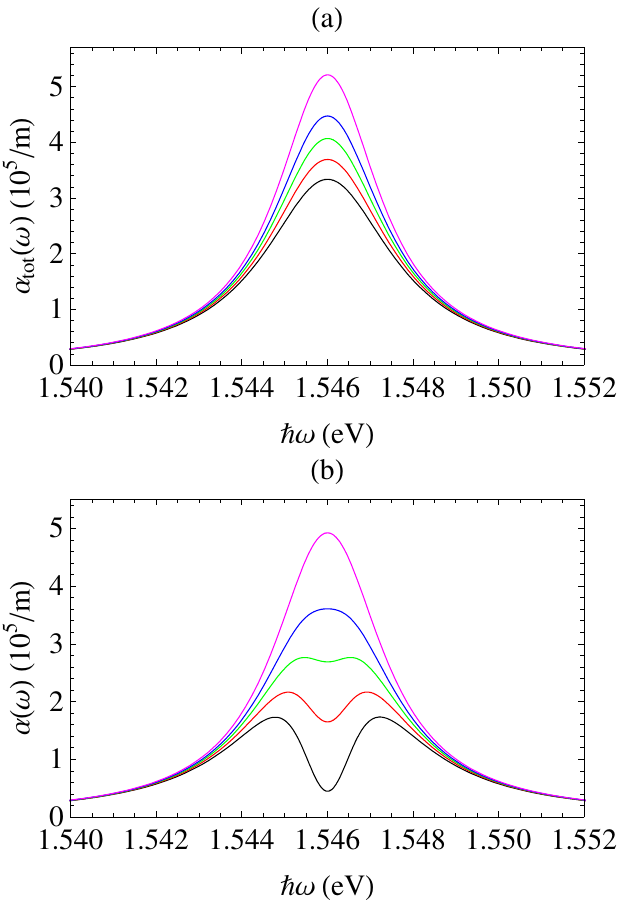
Figure 2. (Color online) The OAC α tot ( ω , I , d ) ( a ) and α ( ω , I , d ) ( b ). The various curves are for different distances from the surface of the metallic nanoparticle: d = 80 nm (black curve), d = 15 nm (red curve), d = 10 nm (green curve), d = 7.5 nm (blue curve), and d = 5 nm (magenta curve). The intensity is I = 9 × 10 9 W/m 2 and the field is polarized along the z axis.